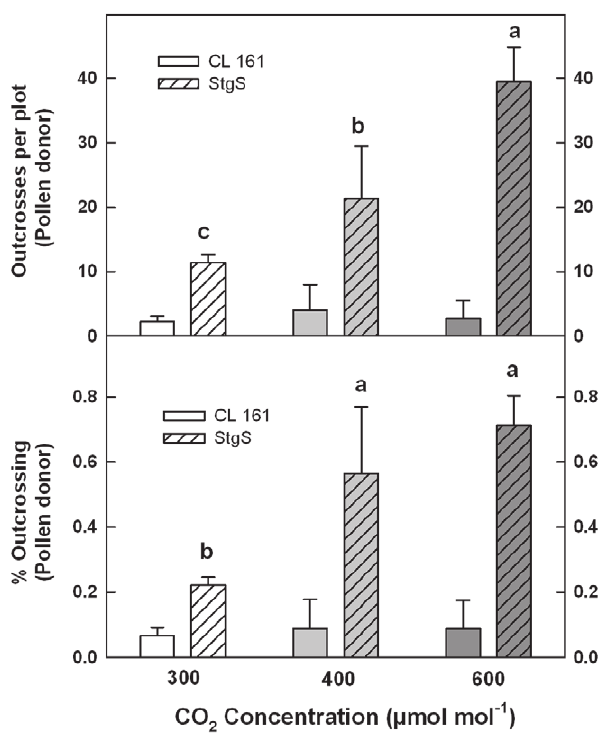
Figure 3. Percent outcrossing and outcrosses per plot for the pollen donor as detected in cultivated and wild rice popula- tions in the field plots. Outcrosses were always significantly higher for the StgS relative to the CL 161 population regardless of CO 2 concentrations (not shown). Different letters indicate a significant population by CO 2 concentration interaction for lthe StgS relative to the CL 161 population. Bars are 6 SE